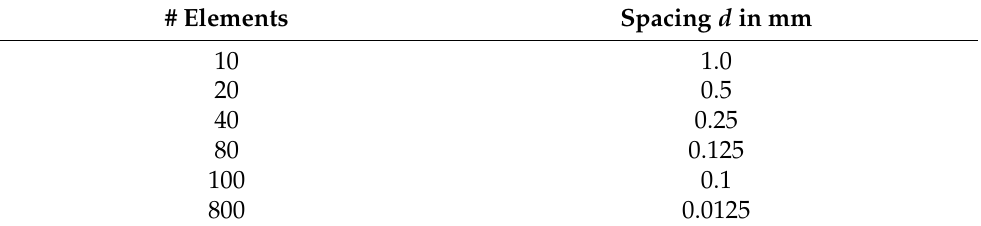
Table 2. Table of the grid spacing for the computational domains used.